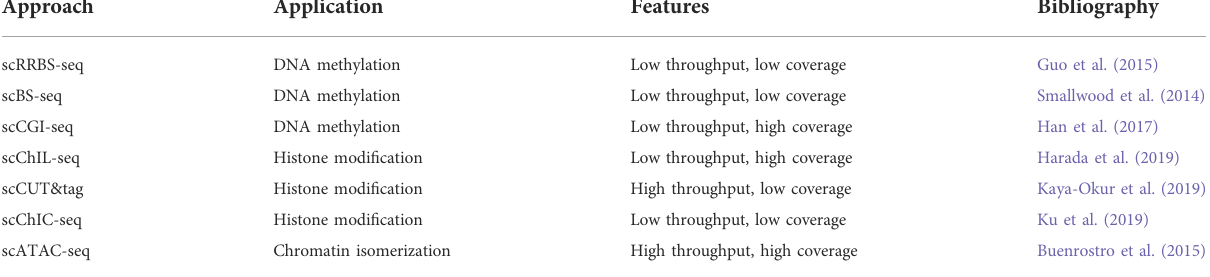
TABLE 4 Comparison of different scEpig-seq technologies. Approach Application scRRBS-seq